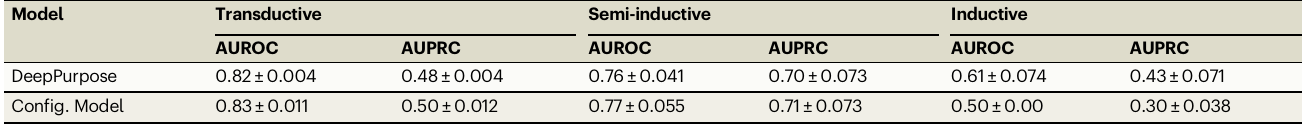
Table 2 | DeepPurpose and duplex con fi guration model performances on BindingDB dataset Model